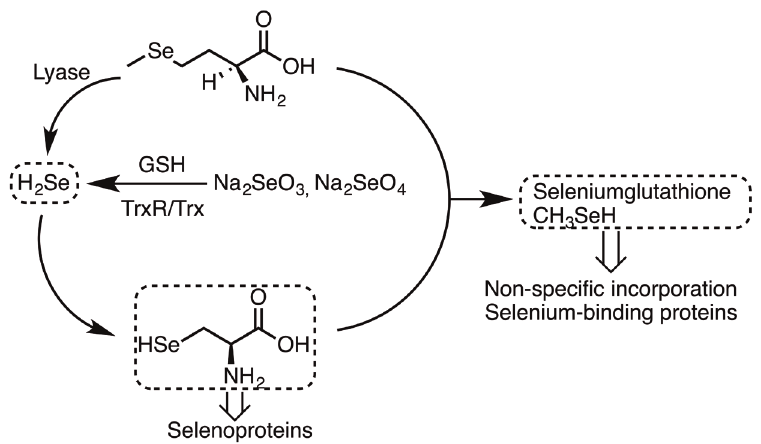
Figure 40 - Selenium metabolism pathway in